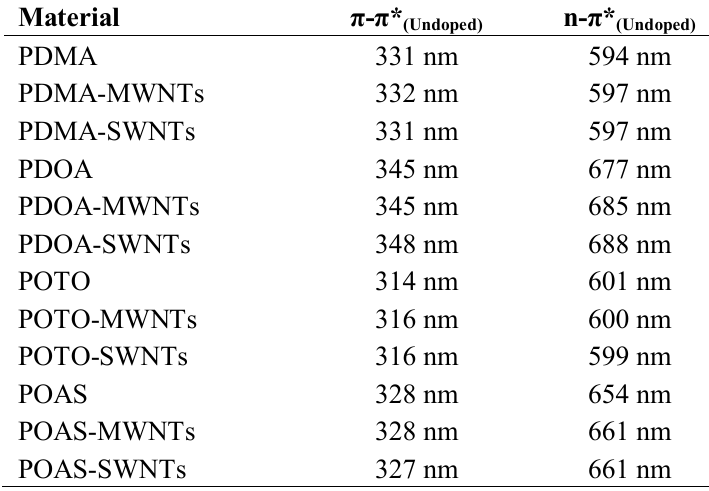
Table 2. Wavelength of the peaks related to the π-π* and n-π* transitions for all materials in the undoped